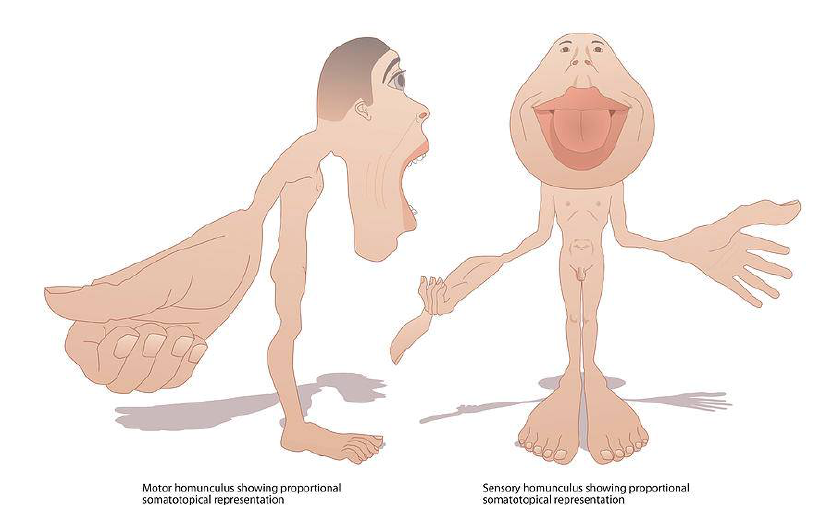
Figure 11. Peter Gardiner, Humunculus illustration graphs onto a human form the relationship between the geography of a point on the outside of the body to a point in the central nervous